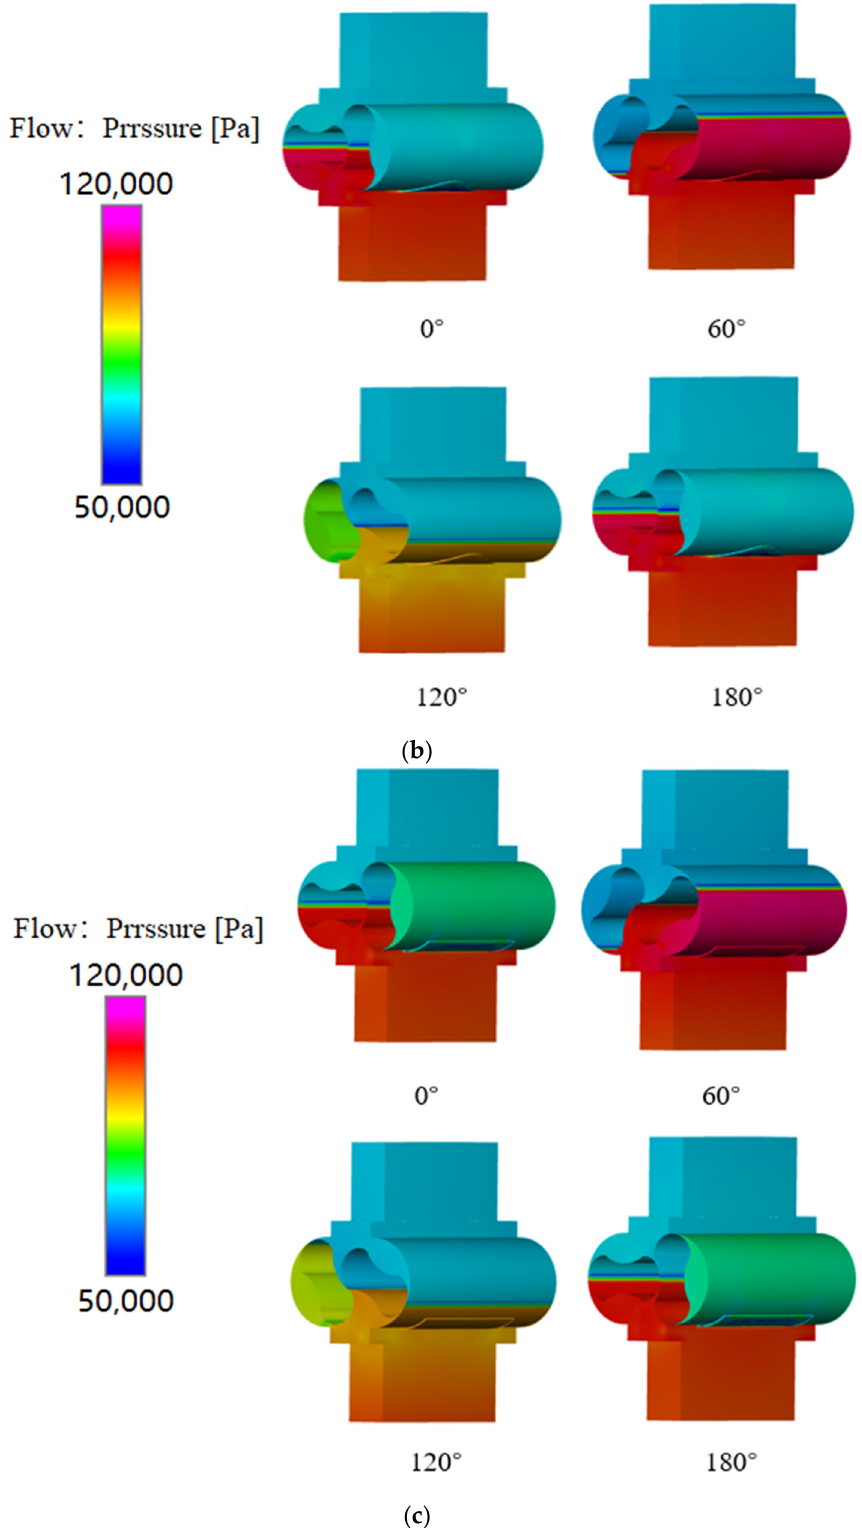
Figure 19. A comparison of the pressure clouds: ( a ) original model; ( b ) optimization Model 14; ( c ) optimization Model 5.